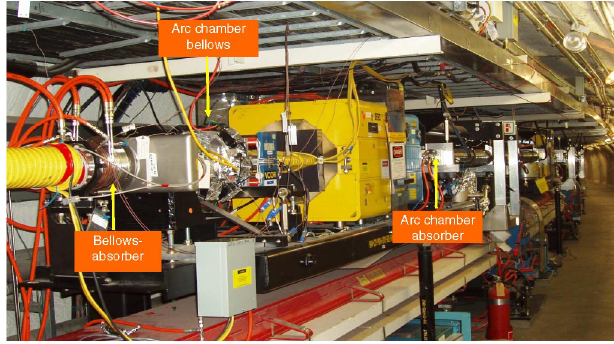
FIG. 14. (Color) SLAC PEP-II tunnel where the bellows ab- sorber is installed.